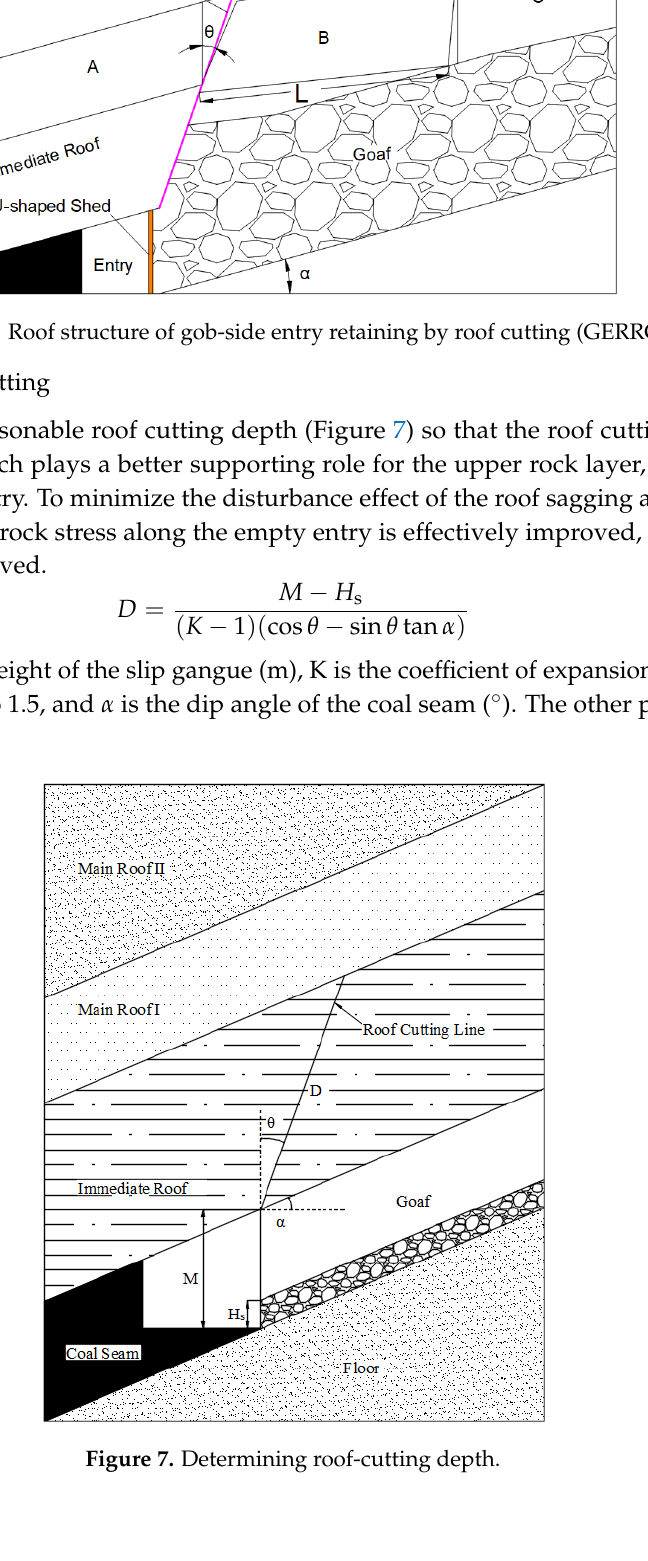
Figure 7. Determining roof-cutting depth.